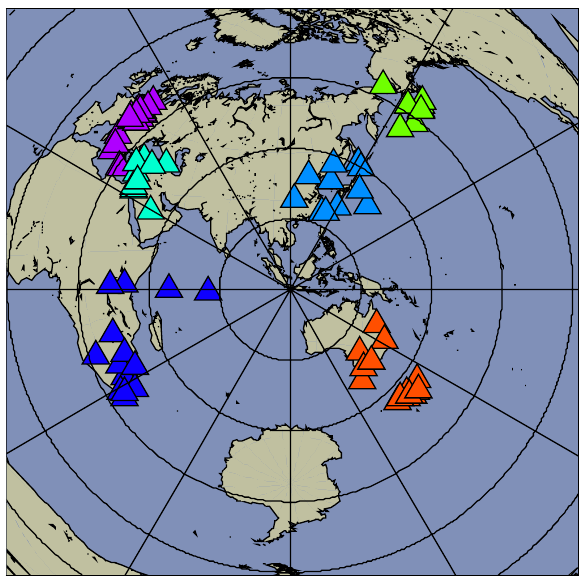
Fig. 1. Map of stations used for semblance analyis of the M 7 . 4 Java earthquake on 2 September 2009 (centre of the map). Stations are located within epicentral distances of 30 ◦ –100 ◦ . Colours indicate the different arrays used for data